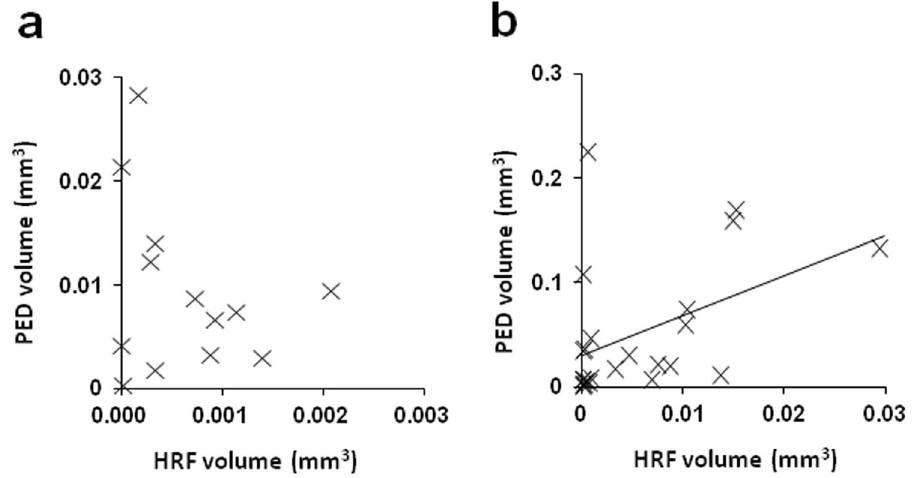
Figure 6. Scatterplots of the HRF and PED volumes. ( a ) Drusenoid PED group. ( b ) Serous PED group. All abbreviations used are as defined in the figure legends for Figs 1 and